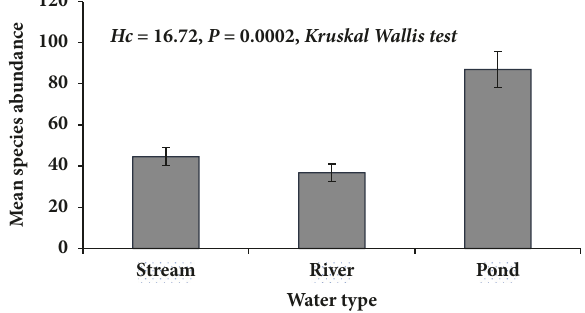
Figure 3: Mean Odonata species abundance among the various water types.